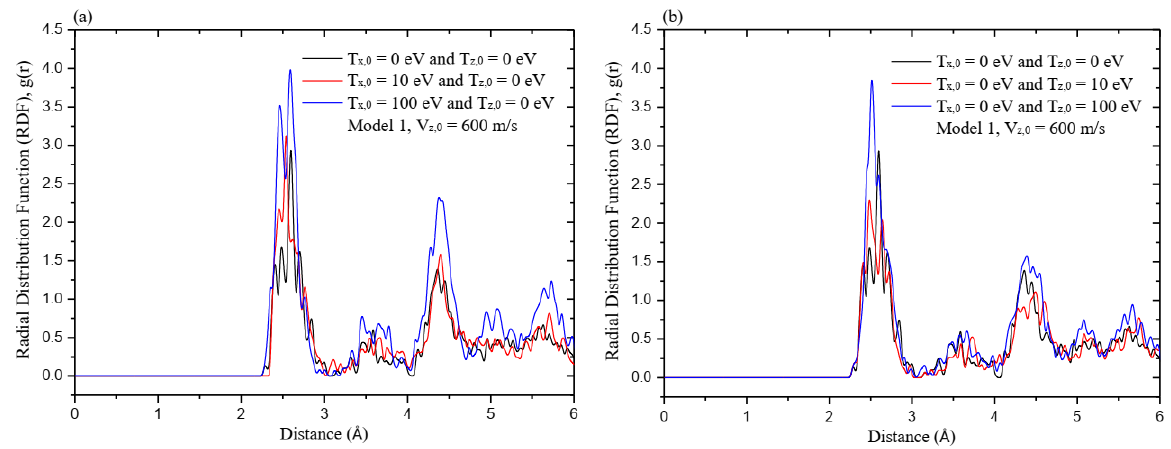
Figure 10. RDFs in Model 1: ( a ) T z ,0 = 0 eV and various T x ,0 and ( b ) T x ,0 = 0 eV and various T z ,0